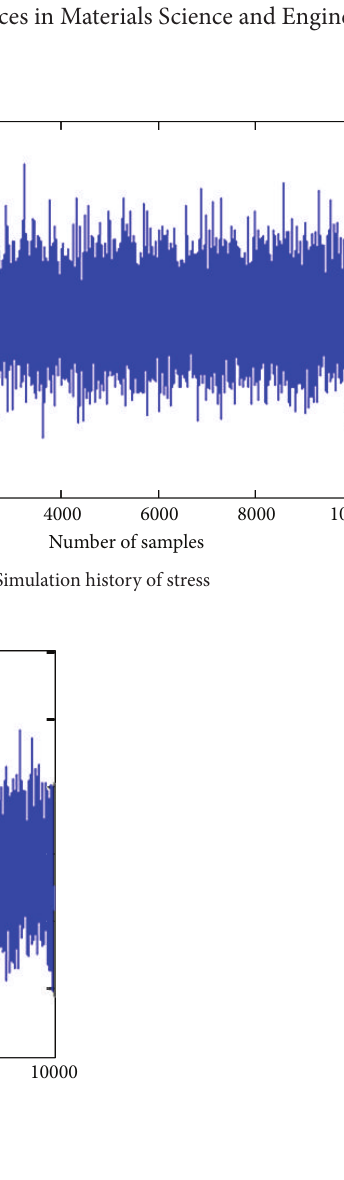
Figure 9: Simulation samples of turbine